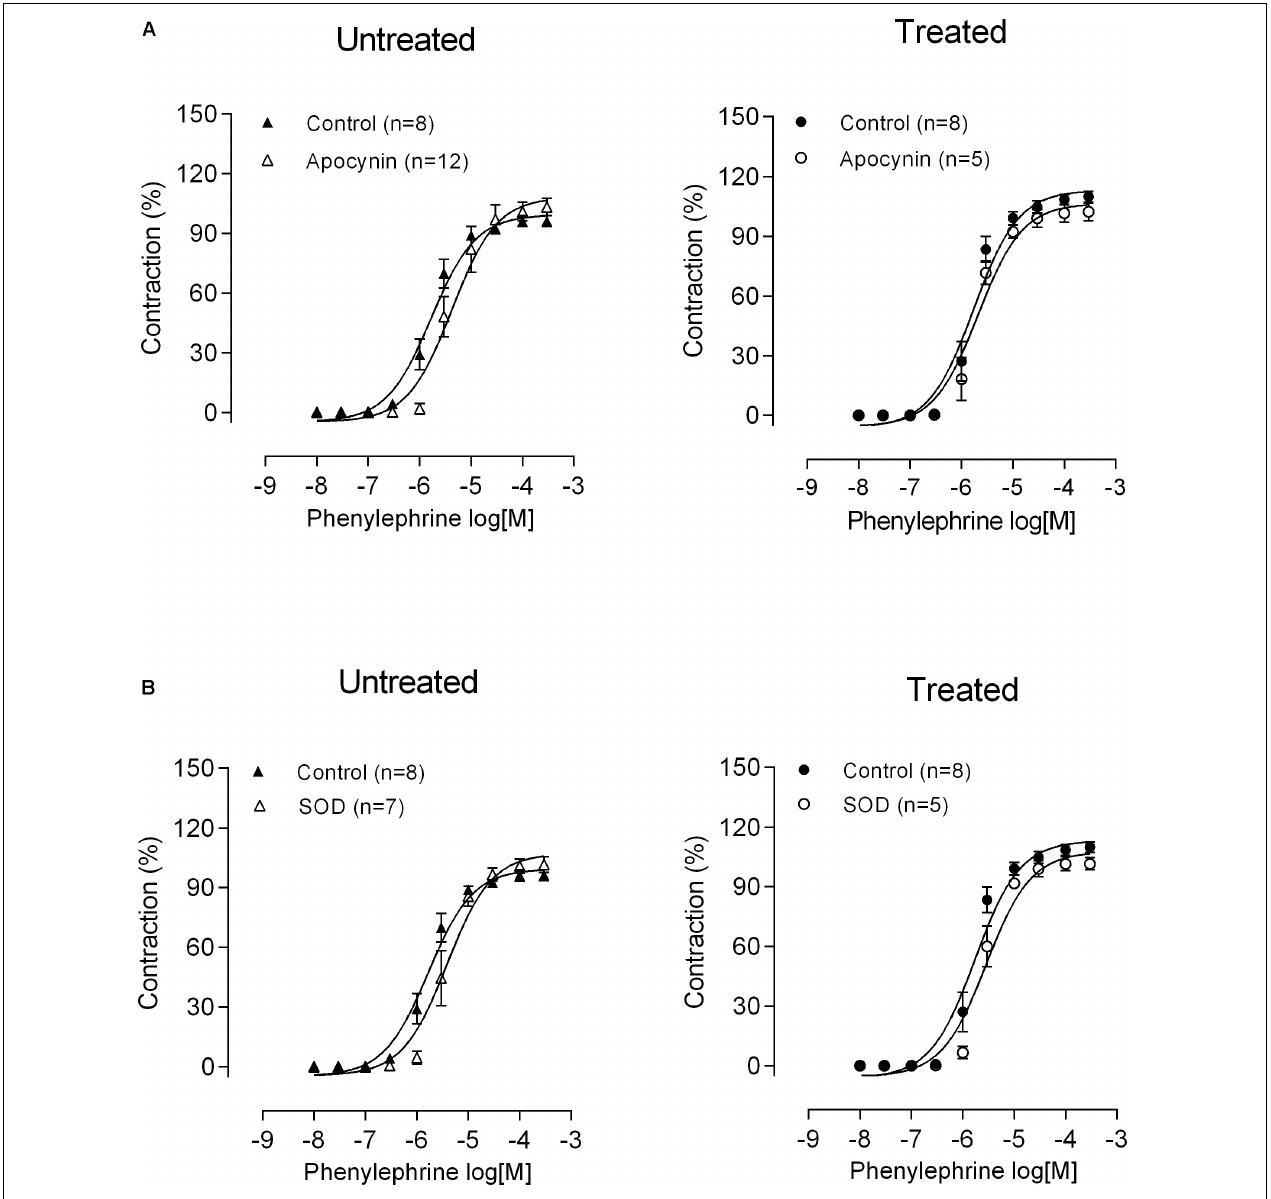
FIGURE 3 | Role of oxidative stress in altered phenylephrine responses after lead treatment. The effects of (A) apocynin and (B) SOD on the concentration-response curve to phenylephrine in mesenteric rings from untreated and treated rats; Data are expressed as the mean ± SEM. P > 0.05 versus control. n denotes the number of animals